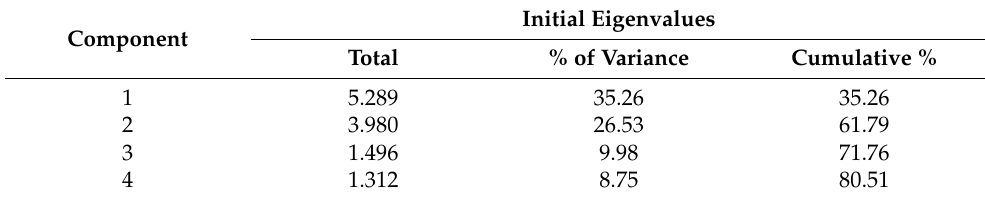
Table 1. Principal component scores between different groups within Musaceae. The table shows cor- responding variation from the first four components with eigenvalues greater than 1 of 15 quantitative male floral morphological characters of 59